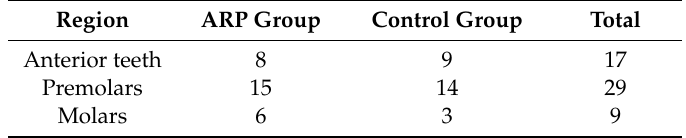
Table 5. Distribution of the teeth of 55 patients according to their positions in the jaw.